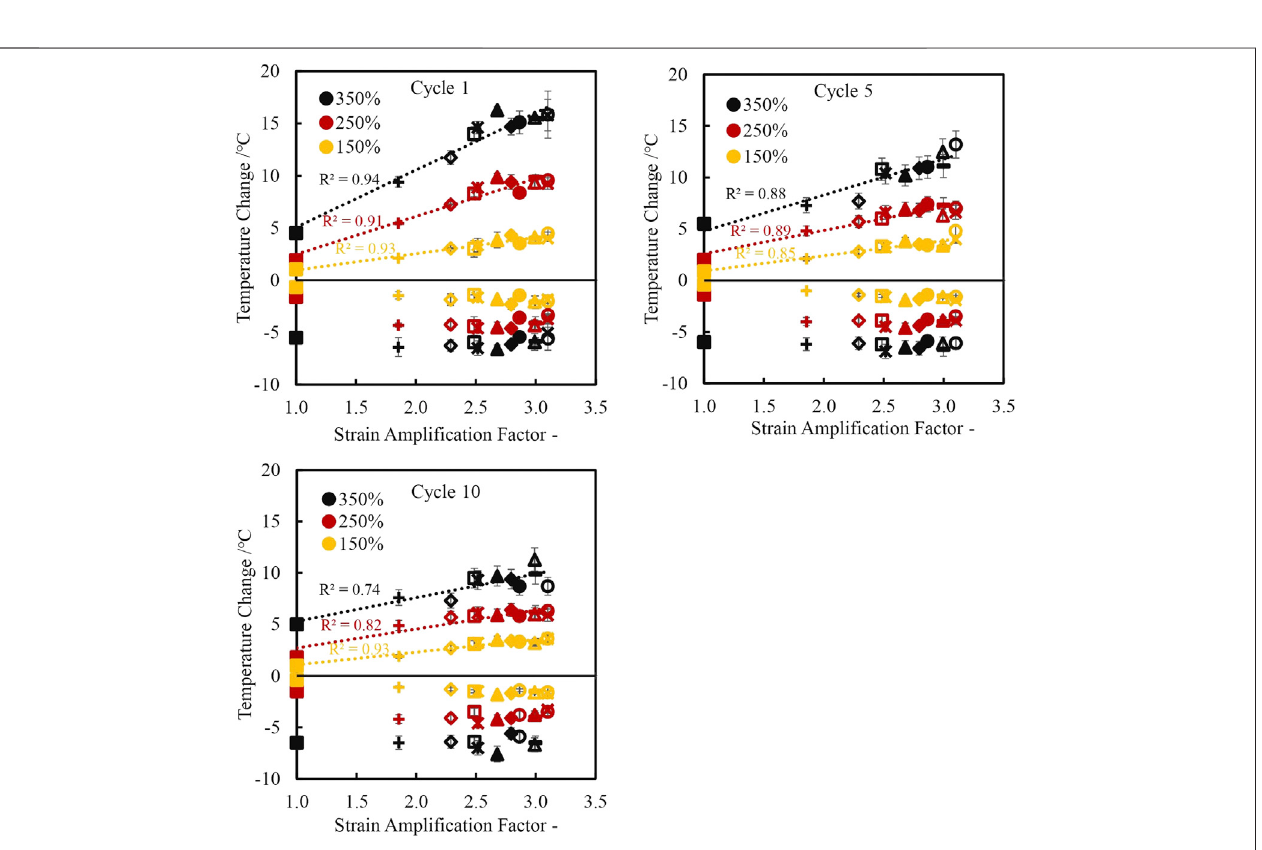
FIGURE8| Temperaturechangeasafunctionofstrainampli fi cationfactorofcarbonblackreinforcedandunreinforcednaturalrubberextendedoncycles1,5and 10. Positive values are the temperature rise upon extension and negative values are the corresponding temperature drop upon retraction.